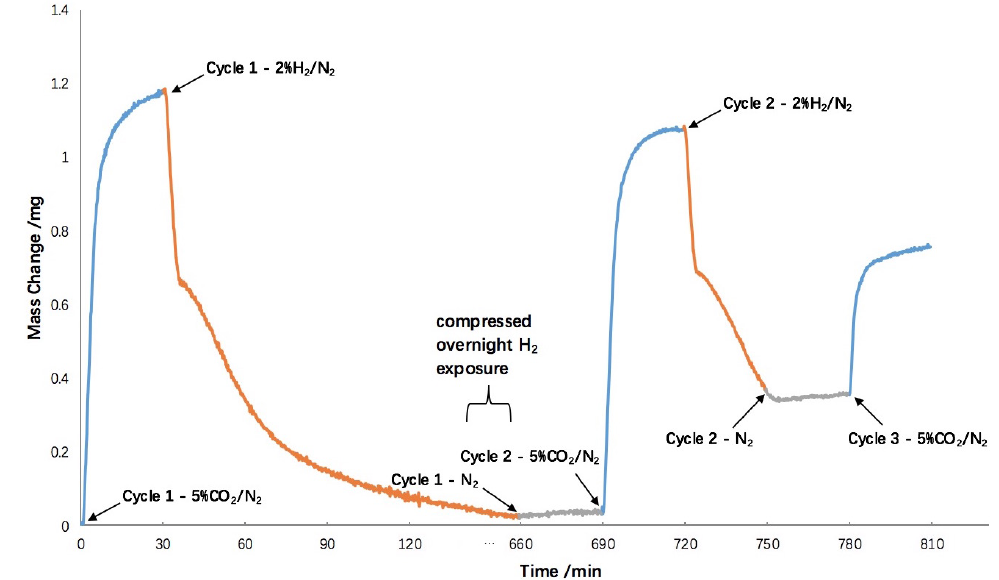
Figure 3. TGA result of the 3-cycle test for 50 mg of 5% Ru, 10% Na 2 CO 3 /Al 2 O 3 at 320 °C. The plot excluded the over-night activation step at 320 °C in 2% H 2 /N 2 . The long tail of low weight loss in the first cycle was compressed indicating an overnight (10.5 h) hydrogen exposure at 320 °C.